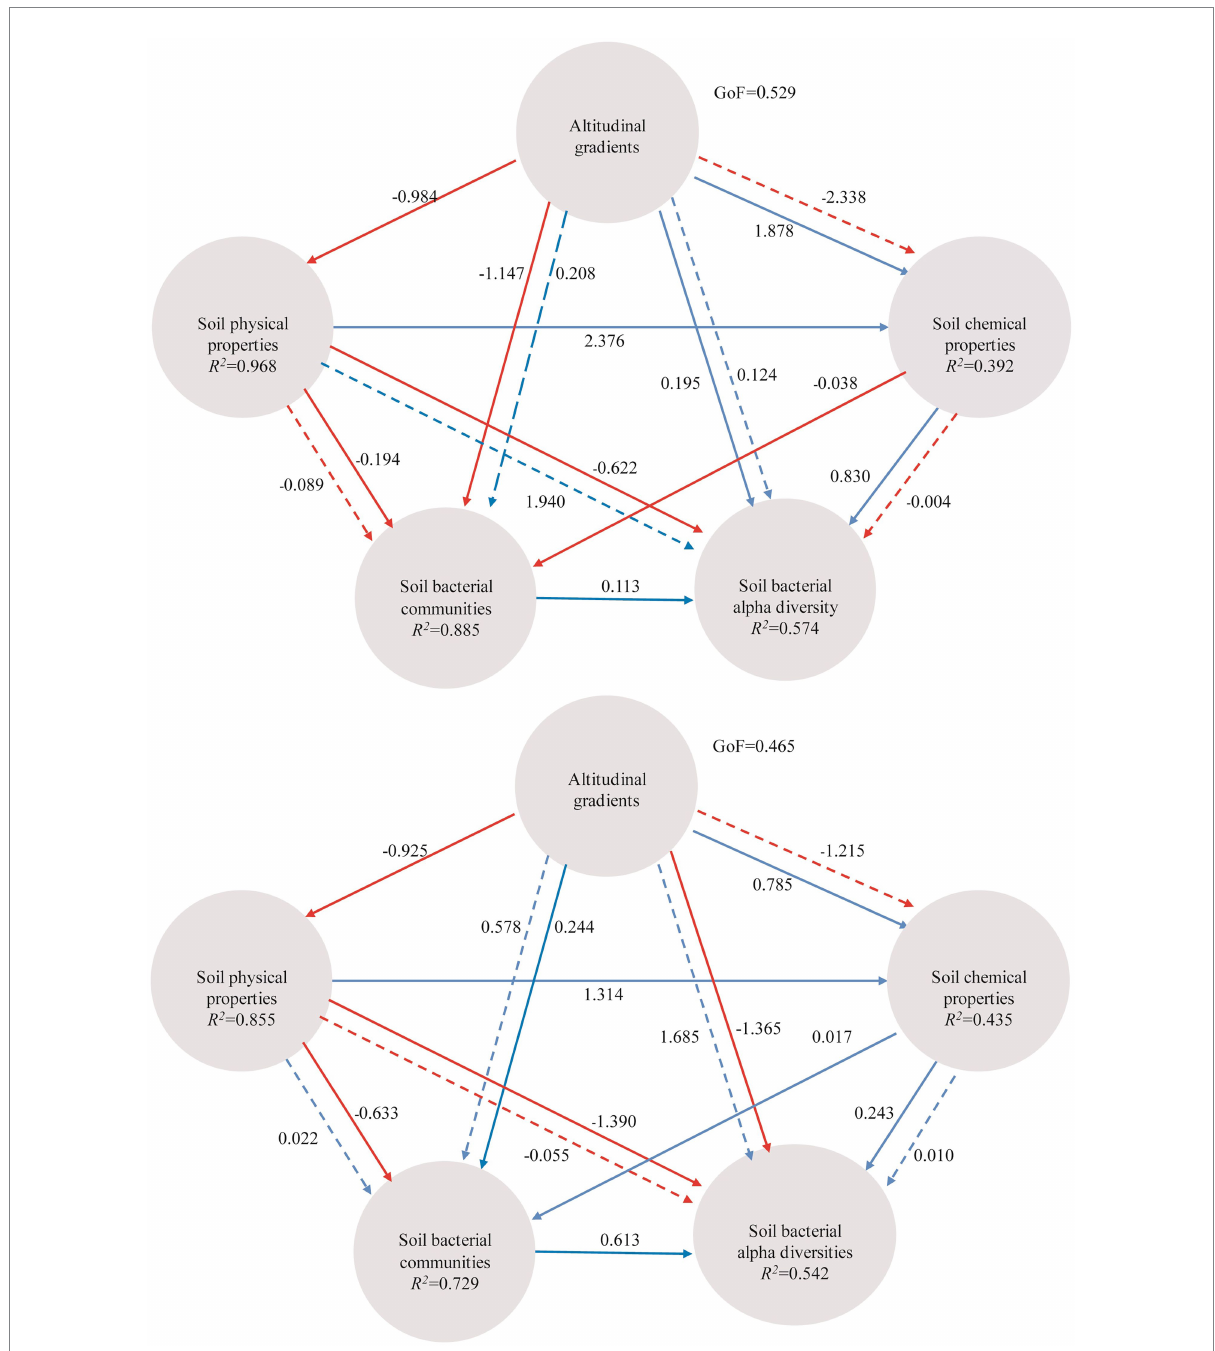
FIGURE 7 PLS-PM indicating the relationships between altitudinal gradients, soil physical properties (T, EC, and SM), chemical properties (SOC, TP, AK, pH, and TN), soil bacterial communities based on the most abundant OTUs and soil bacterial alpha diversities (Shannon, Simpson and observed OTUs). The path coefficients and the explained variability ( R 2 ) are calculated after 999 bootstraps and reflected in the arrows with blue and red indicating positive and negative effects, respectively (solid line represents direct effect and dotted line represents indirect effect). Models with different structures were assessed using the Goodness of Fit (GoF) statistic, a measure of the overall prediction